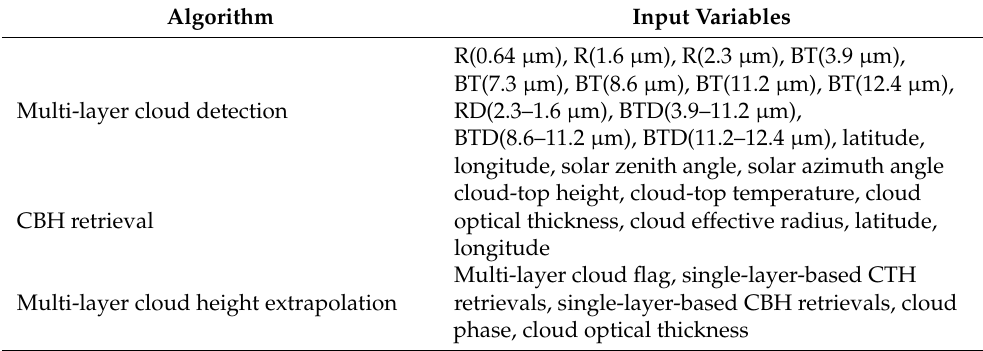
Table 1. Input variables for three algorithms used in this study. Algorithm